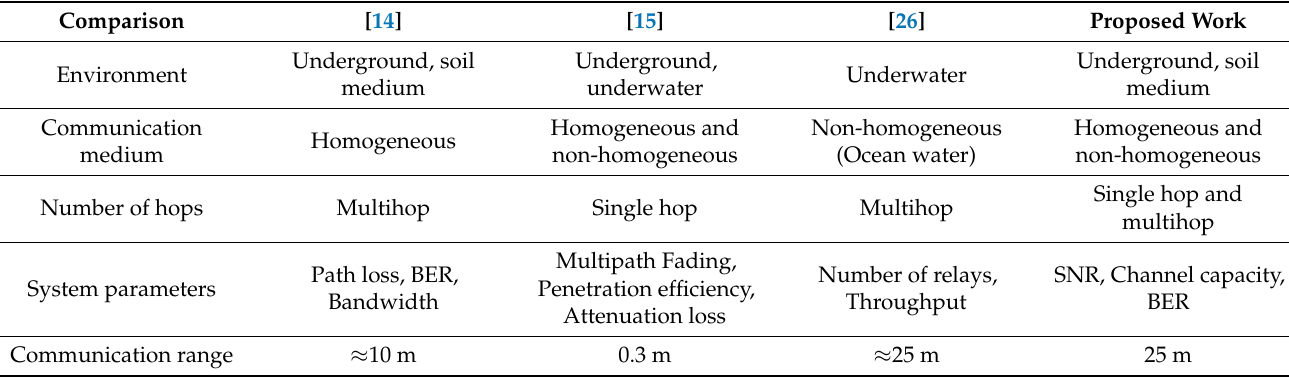
Table 1. A summary of comparison between this work and other